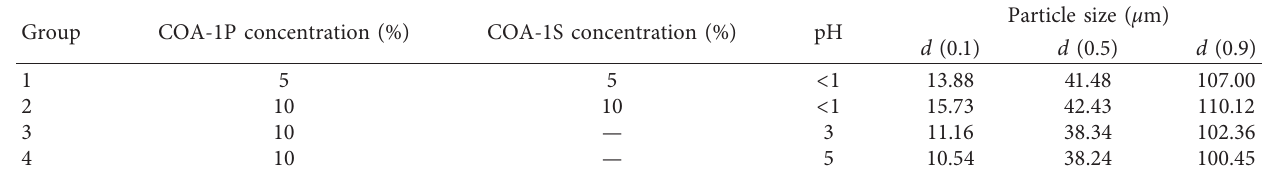
Table 2: Particle size distribution of the mixed solution of COA-1P and COA-1S.